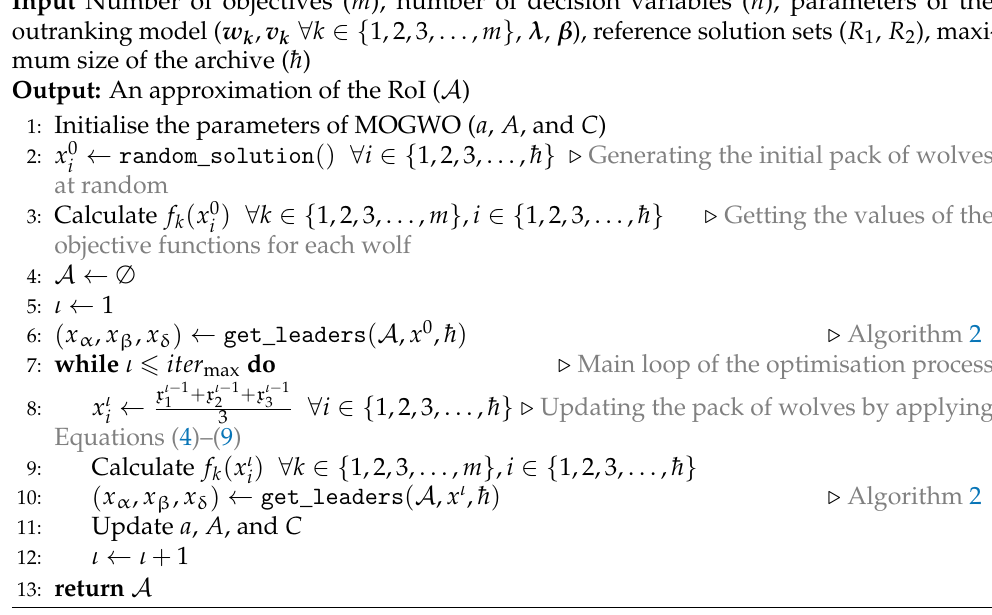
Algorithm 3 The Grey Wolf Optimiser with Interval outranking-based ordinal Classification